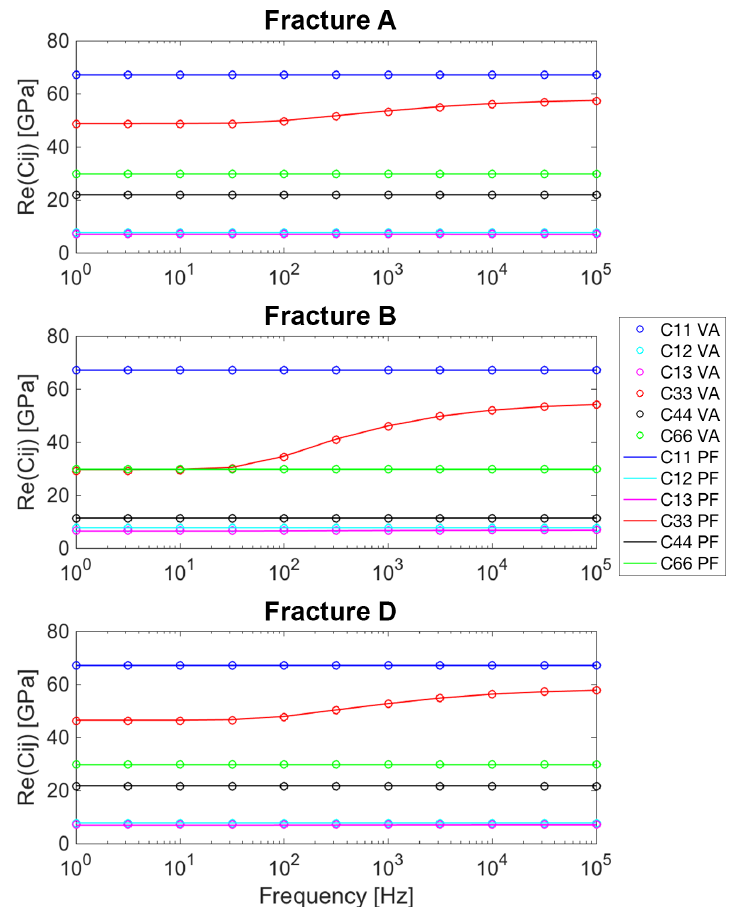
Figure 10. Real part of the components of the effective stiffness matrix as functions of frequency. Circles correspond to numerical simulation for fracture models A, B and D with variable aperture (VA) distributions shown in Fig. 5 (fracture model C was omitted due to its negligible P-wave modulus dispersion). Solid lines correspond to the analytical solution of Krzikalla and Müller (2011) for planar fracture (PF) models using equivalent fracture properties (Table